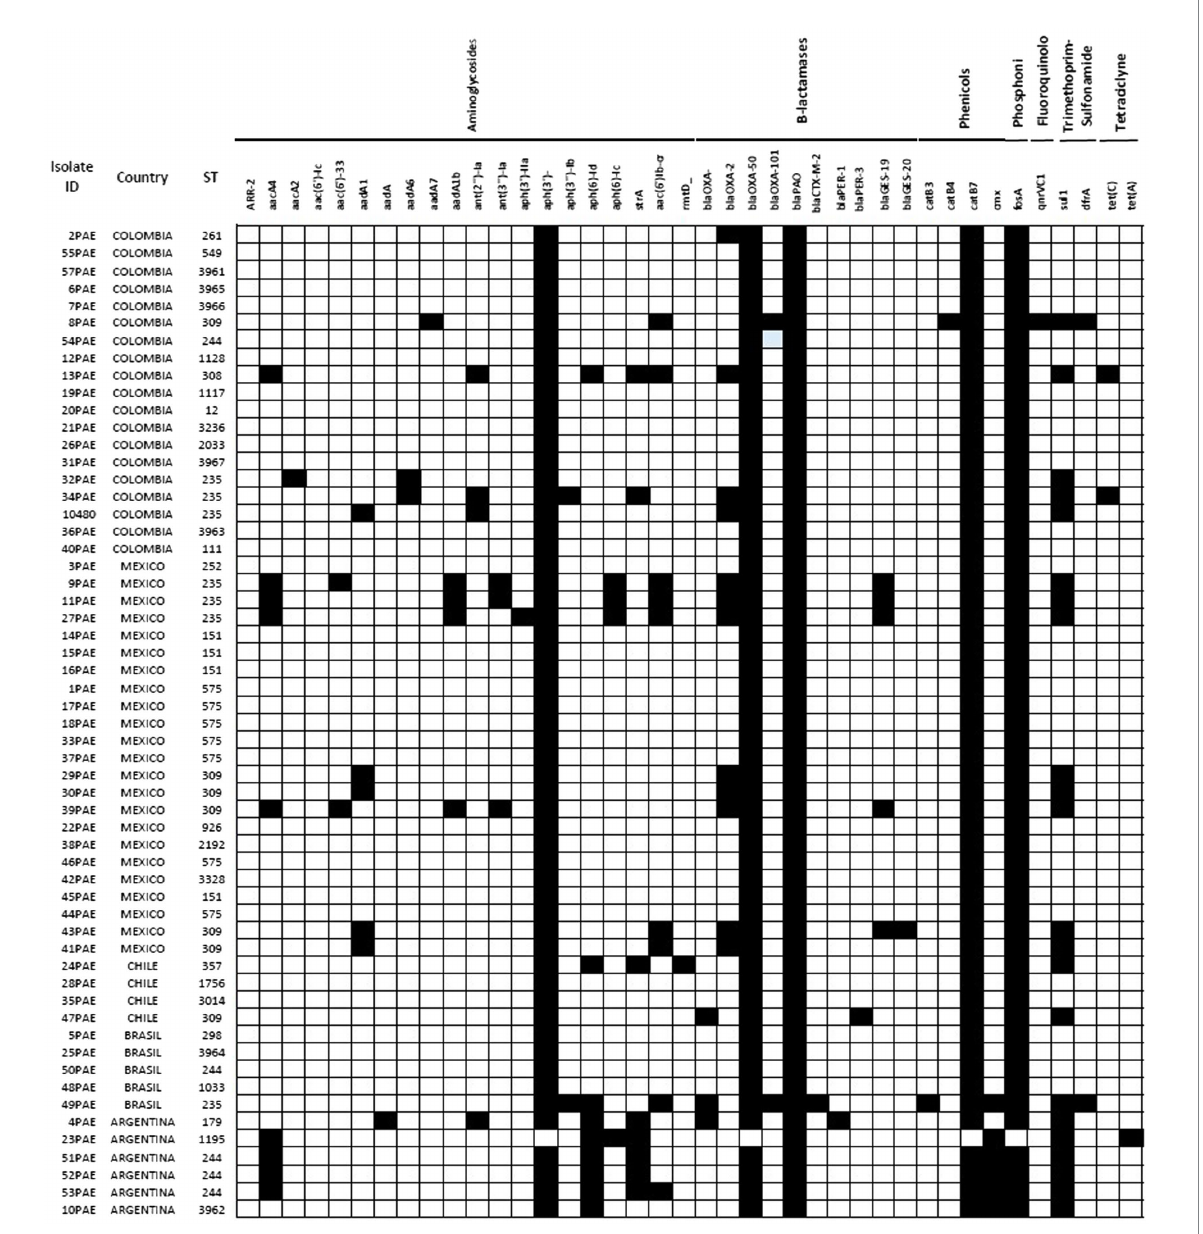
FIGURE 1 Principal phenotypic and genomic characteristics of the Pseudomonas aeruginosa TOL-resistant isolates sequenced. Black squares mean presence, white squares mean